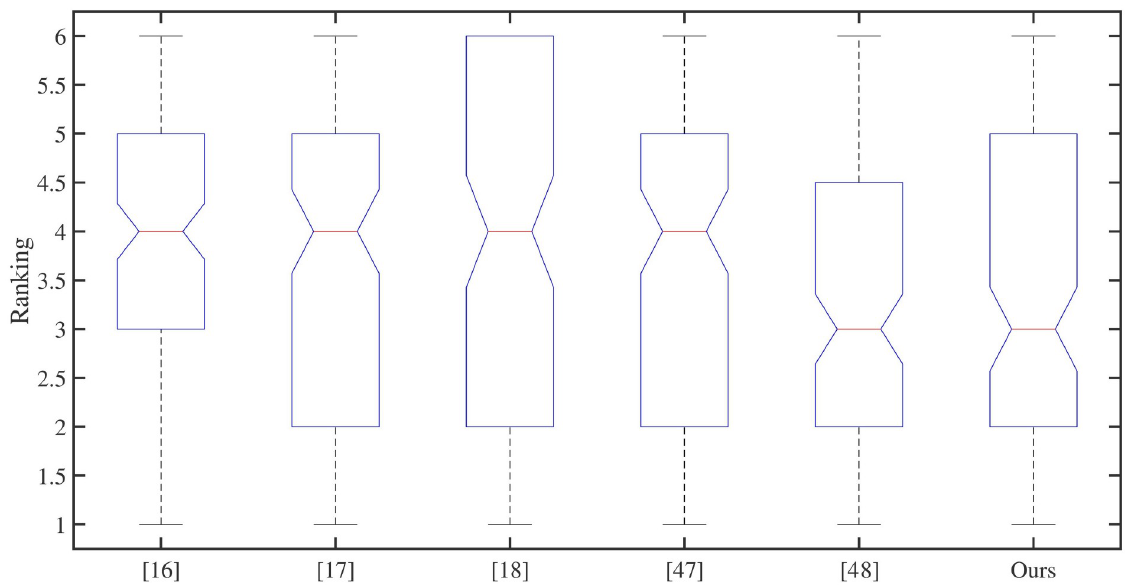
Fig 9. Ranking distribution of coloring effects of six algorithms. Each group of images contains the coloring results of six algorithms, which are sorted in ascending order of 1–6. No parallel ranking is allowed in the same group of images. Among them, the smaller the sorted number, the better the coloring effect processed by the algorithm.